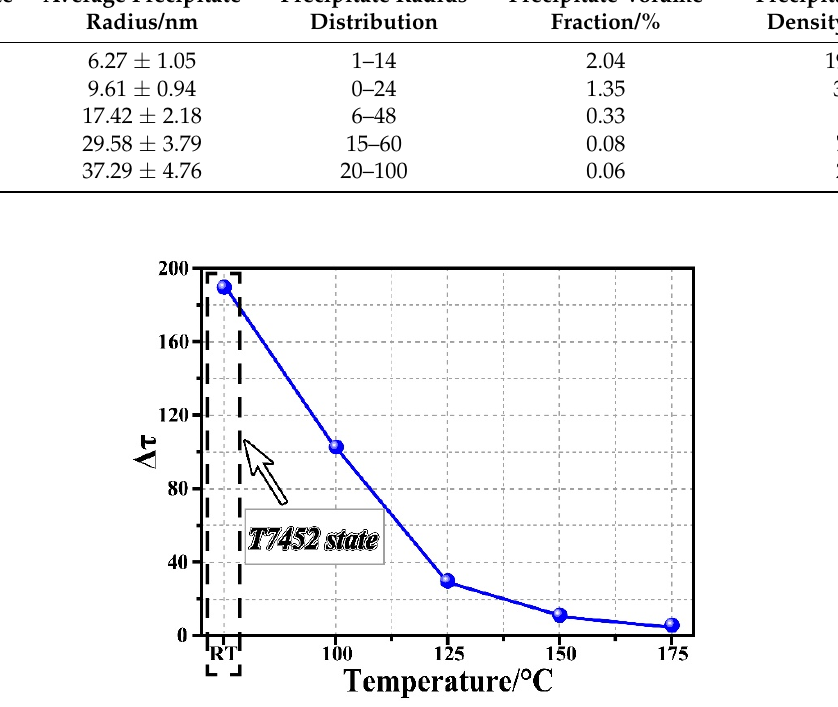
Table 3. The precipitate parameters of the samples after different heat treatment processes. Precipitate Sample Type